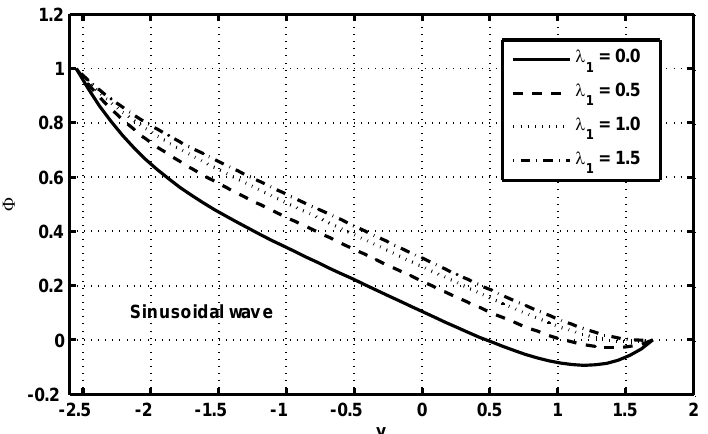
Figure 14. Concentration profile for di ff erent values of λ 1 for fixed a = 0.5, b = 1.2, d = 1.5, ϕ = π γ = 0.0009, η = 0.009, η = 0.001, k = 0.2, M = 0.9, Pr = 1, Q = 5, Sc = 0.6, Sr = 0.4, 1 2